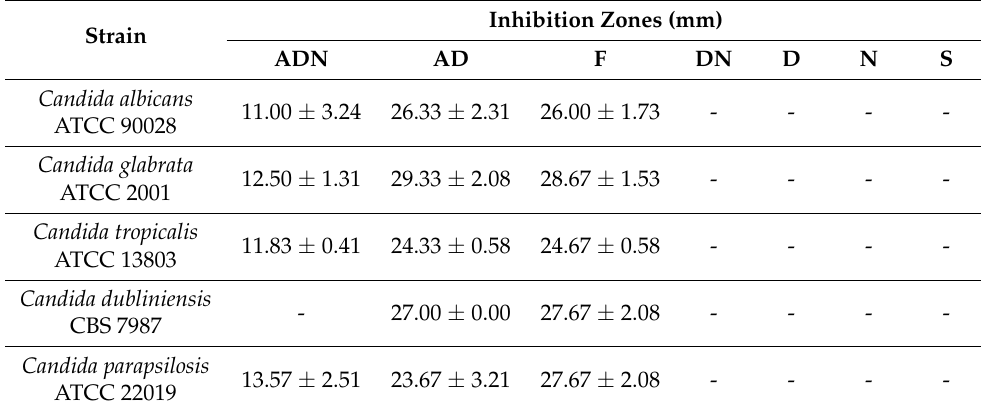
Figure 2. Qualitative evaluation of the in vitro antifungal activity by the agar well-diffusion method. ( A ) Samples application scheme, ( B ) Candida albicans ATCC 90028, ( C ) C. glabrata ATCC 2001, ( D ) C. tropicalis ATCC 13803, ( E ) C. dubliniensis CBS 7987 and ( F ) C. parapsilosis ATCC 22019. ADN, Amphotericin B–loaded nail lacquer; AD, Amphotericin B–DMSO; F, Fungizone ® ; DN, DMSO nail lacquer; D, DMSO; N, nail lacquer; S, saline solution. Table 4. Quantitative evaluation of the in vitro antifungal activity by the agar-well-diffusion